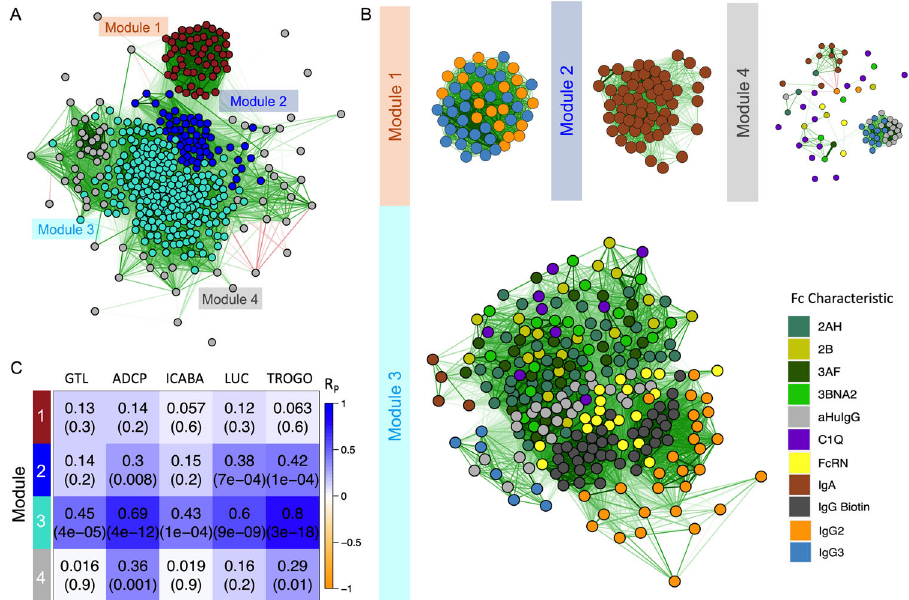
Fig. 7 Multiple antibody functions are associated with a module of speci fi c antibody features. A , B Feature correlation networks. Edges (green lines for positive correlation, red lines for negative correlation) between nodes depict relationships with Pearson correlation coef fi cients ( R P ) < 0.3. A A weighted correlation network of antibody response feature modules was identi fi ed by hierarchical clustering and dynamic tree cutting. Features are colored by module and graphed according to degree and direction of correlation (R P ). B Correlation network for features found within each module. Nodes (features) are colored by Fc characteristic. C Heatmap depicting correlative relationships between antibody functions (columns) and feature module eigenvalues (rows). Pearson correlation coef fi cients (R P ) and p -values are shown in inset. 2AH indicates binding to Fc γ RIIAH, 2B indicates binding to Fc γ RIIB, 3AF indicates binding to Fc γ RIIIAF, and 3BNA2 indicates binding to Fc γ